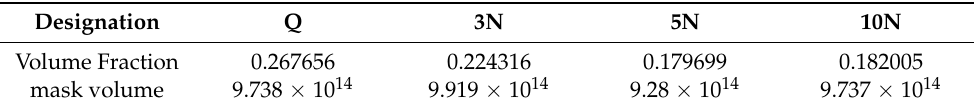
Table 3. Pore ratio of concrete with different sodium sulfate content on the 28th day.